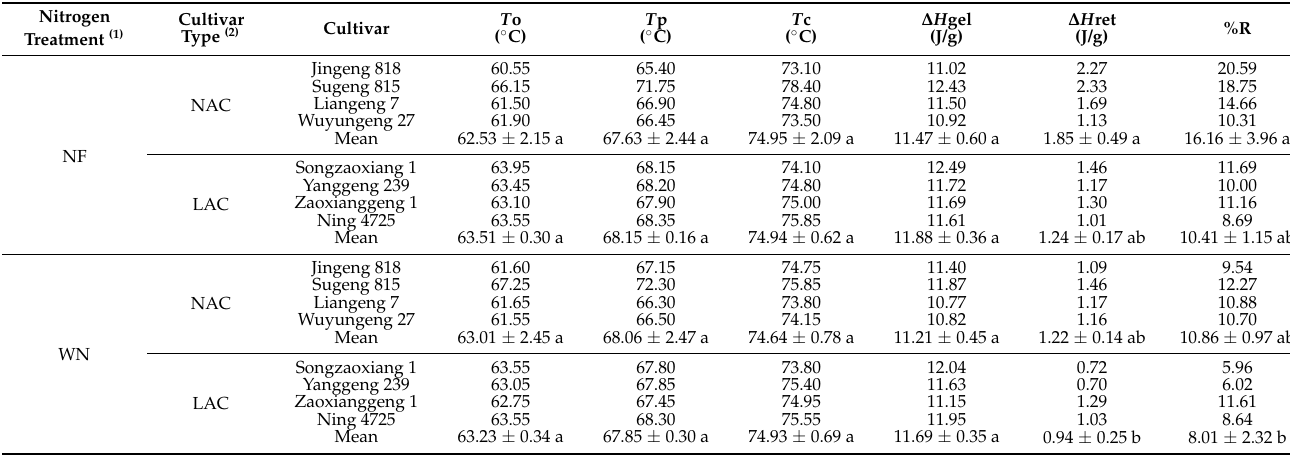
Table 7. Thermal properties of japonica rice cultivar starches with different contents of amylose, grown with or without nitrogen fertilization.